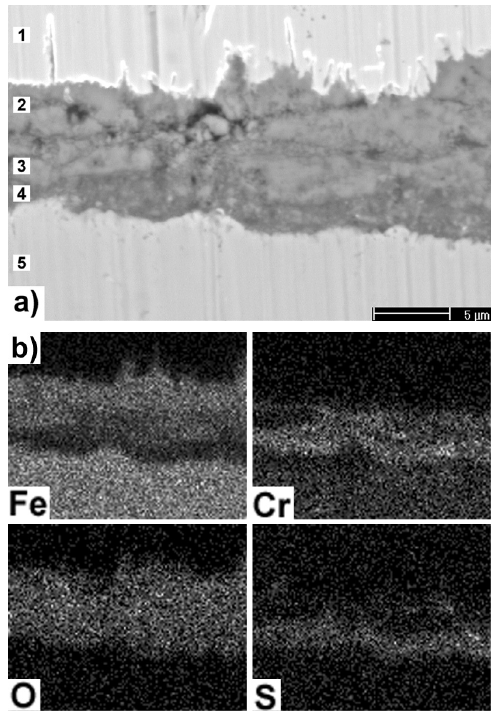
Figure 17. Cross-section of uncoated HCM12A after 336 hours at 883 K in N 2 (cid:3) 100 ppmv HCl (cid:3) 100 ppmv SO 10 % H 2 O (cid:3) 8:4 % O 2 . a) BSE-image. 1) Nickel coating. 2) Fe 2 O 3 . 3) Original surface. 4) Cr-rich layer. 5) Layer in which S can be found. 6) Substrate. b) Corresponding elemental maps for Fe, Cr, O and S.